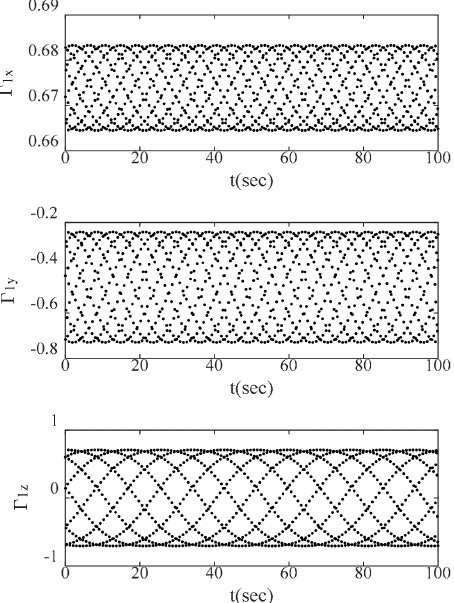
Figure 25. The results of the attitude of z axis under the complete Lie group